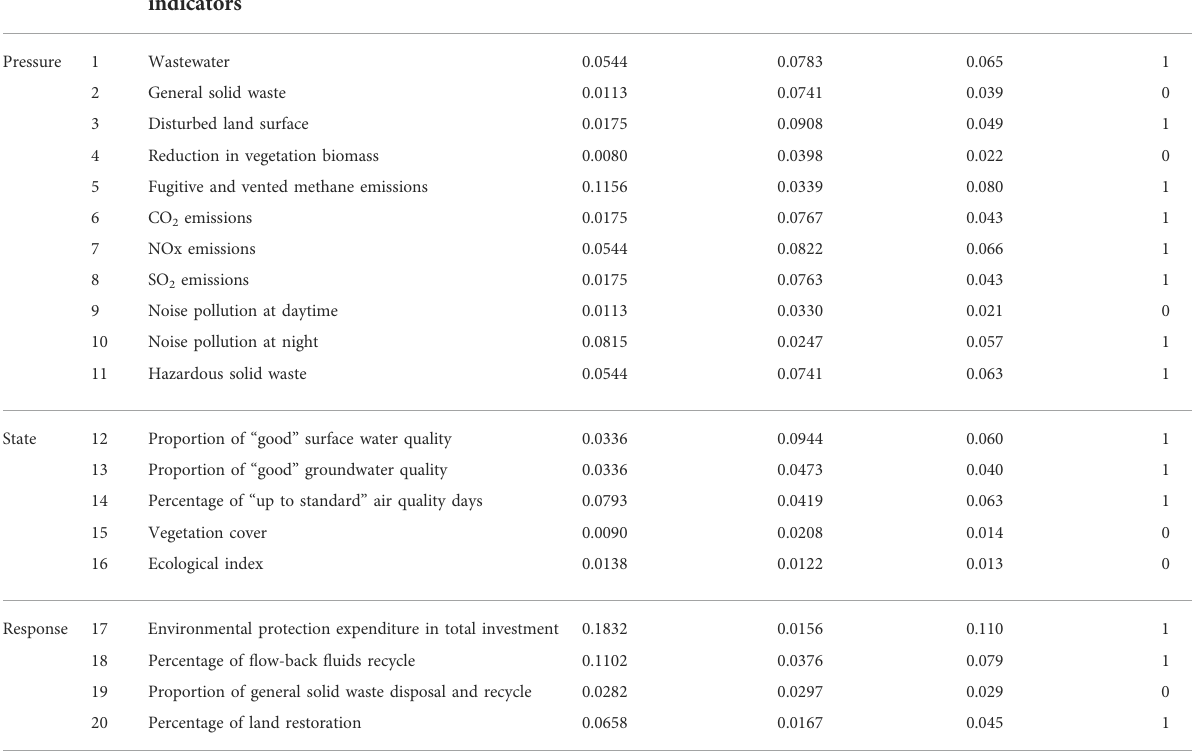
TABLE 2 The twenty key indicators and fourteen tailored indicators of Changning play. Items No. Key (candidate)